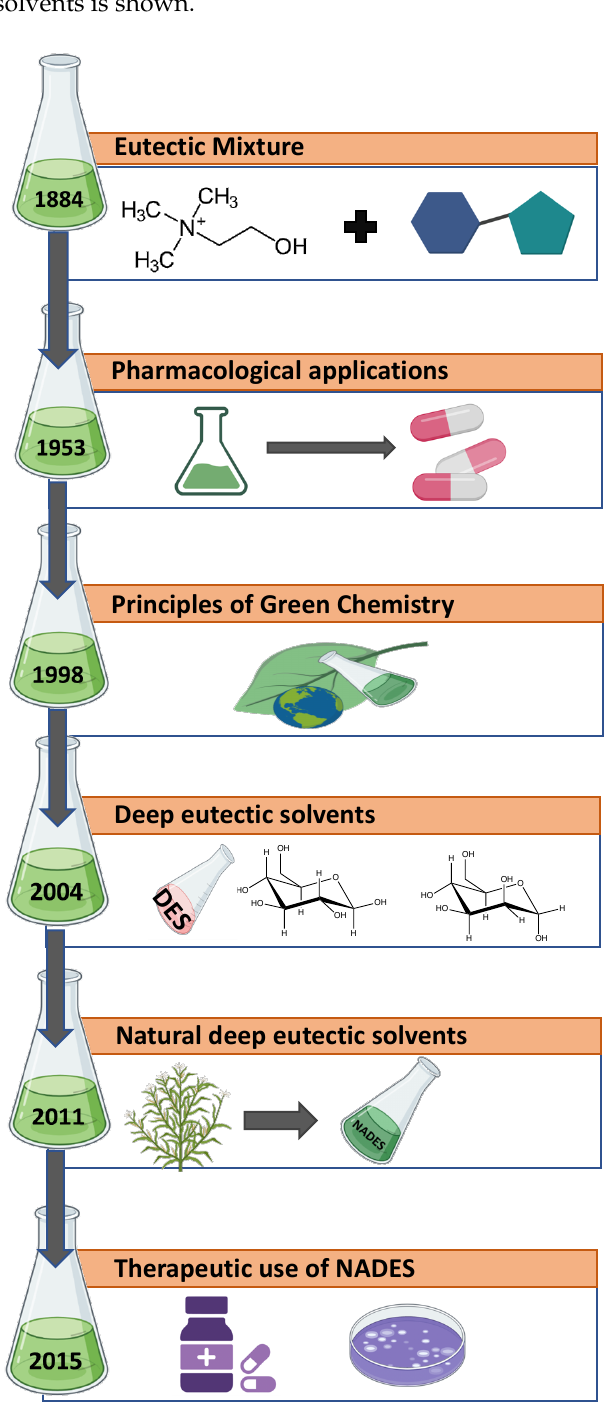
Figure 2. Evolution of DESs over time and their relationship with pharmaceutical